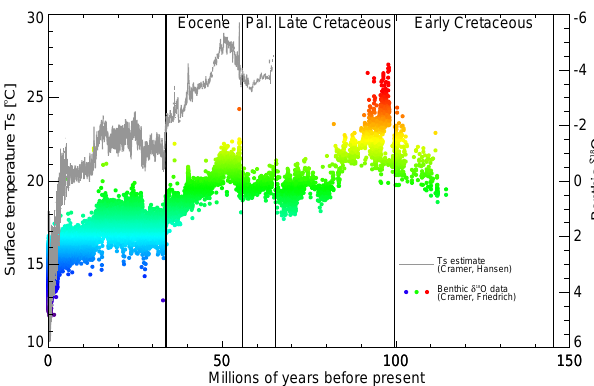
Figure 1. Climate evolution over the last 150million years, as ex- pressed by the benthic oxygen isotope records of Friedrich et al. (2012) and Cramer et al. (2009) (coloured dots), and a surface tem- perature record (H13C09) produced by applying the methodologies of Hansen et al. (2013) to the Cramer et al. (2009) δ 18 O benthic data, and applying a 10-point running average (grey line).